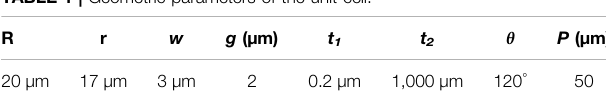
diagnostic techniques for the SARS-CoV-2 S1 protein in both qualitative and quantitative manner that are easily accessible and low-cost.